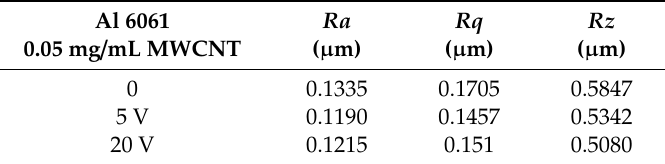
Table 2. Surface Roughness Measurement for Al6061 as received versus samples coated with EDP in a solution of 0.05 mg / mL of MWCNTs. Notice surface roughness average values ( µ m) of the coated samples improve about 16% and 12% for applied voltages 5 and 20 volts,